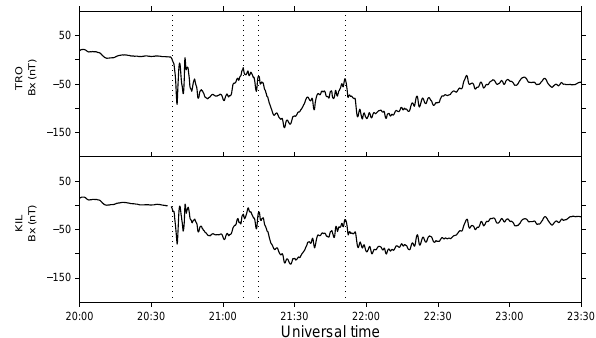
Fig. 6. B x -component magnetograms from Tromsø (TRO) and Kilpisj¨arvi (KIL). Vertical dotted lines are marked at 20:39, 21:09, 21:15, and 21:51 UT for the onset and three intensifications of the